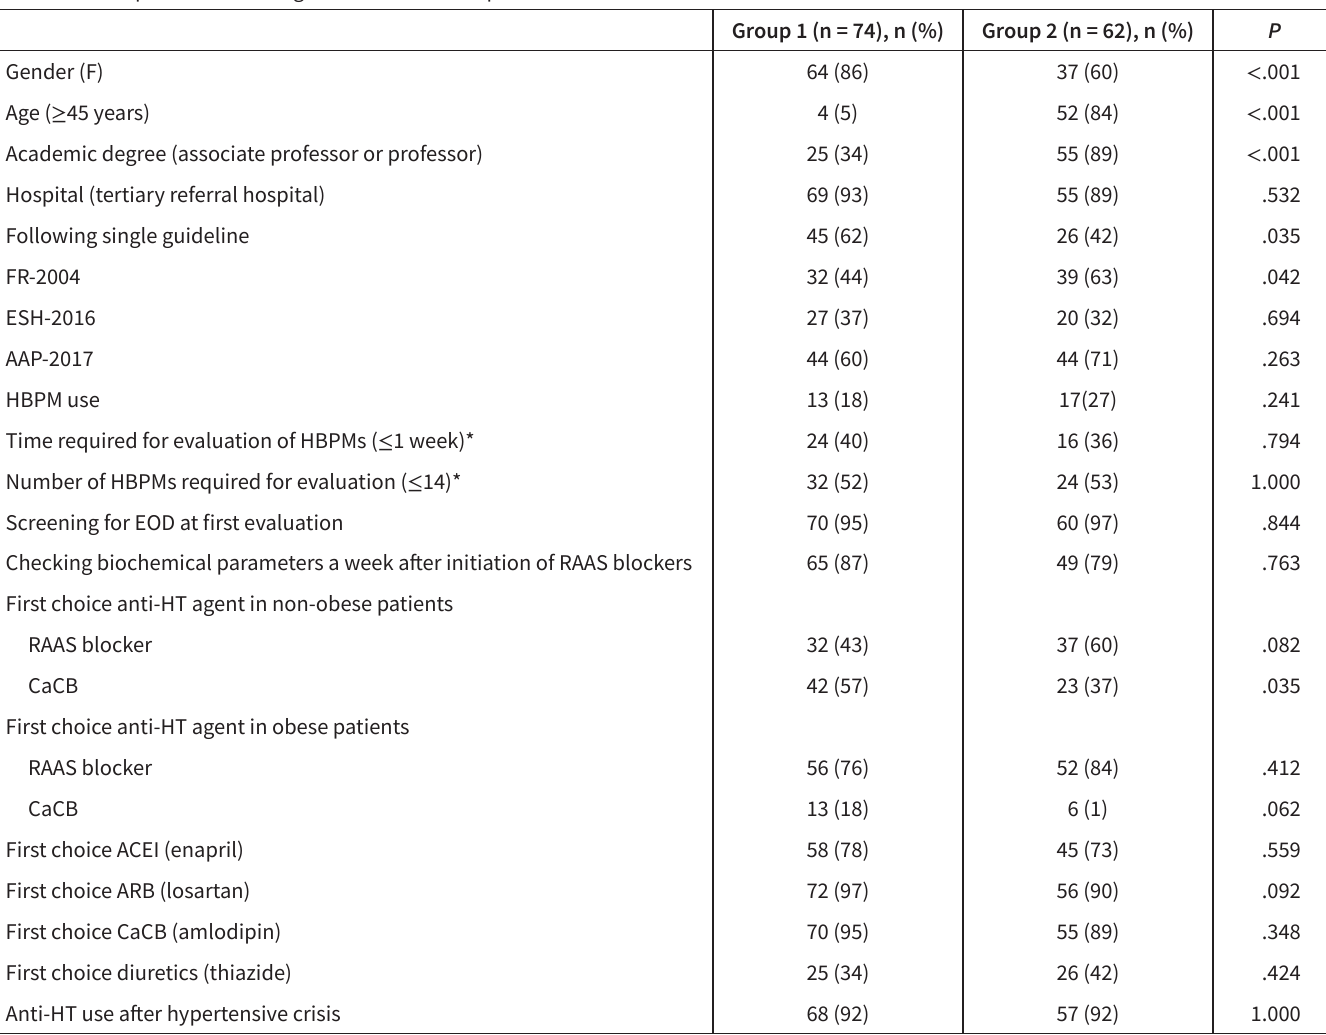
Table 1. Comparison of Findings Between the